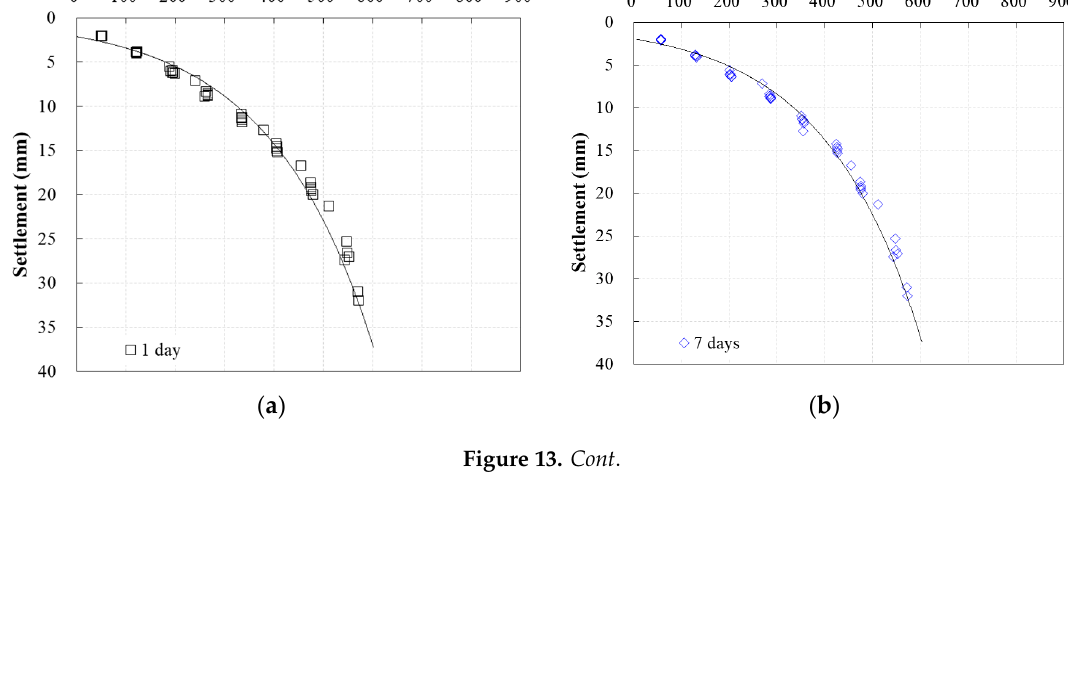
15 of 20 Figure 12. Plate bearing test procedure: ( a ) ground excavation and soil box installation; ( b )